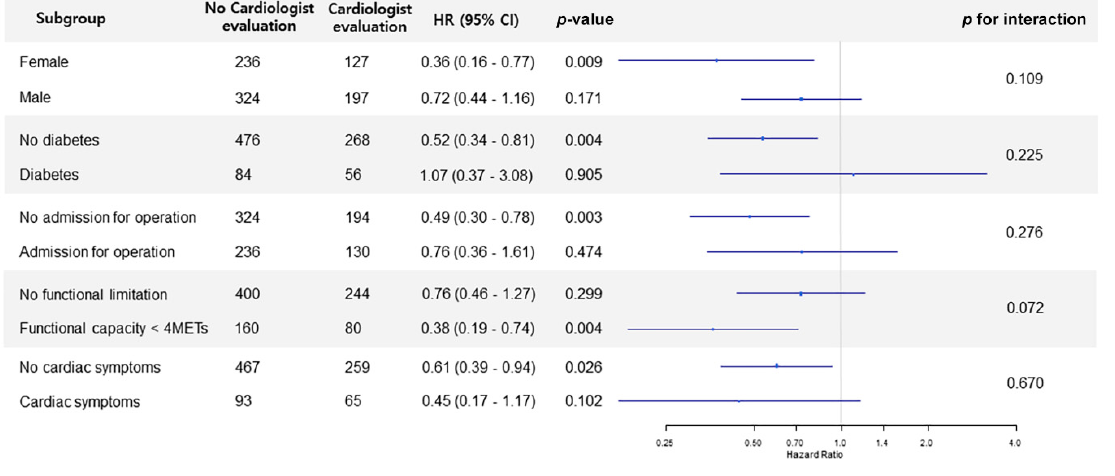
Figure 2. A forest plot of the subgroup